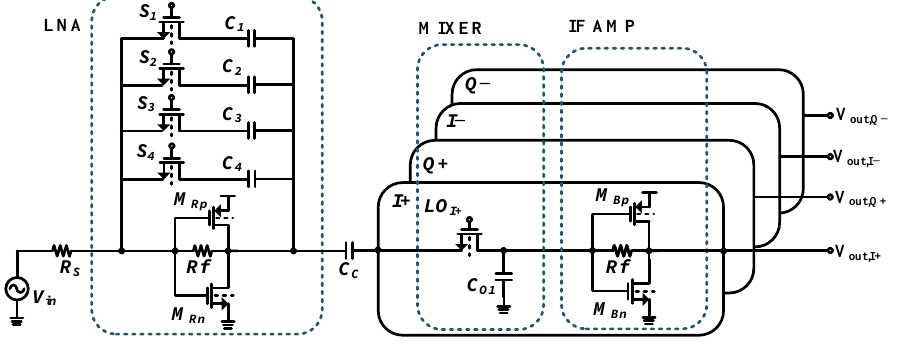
Figure 3. Schematic of the ULP receiver with NPSC